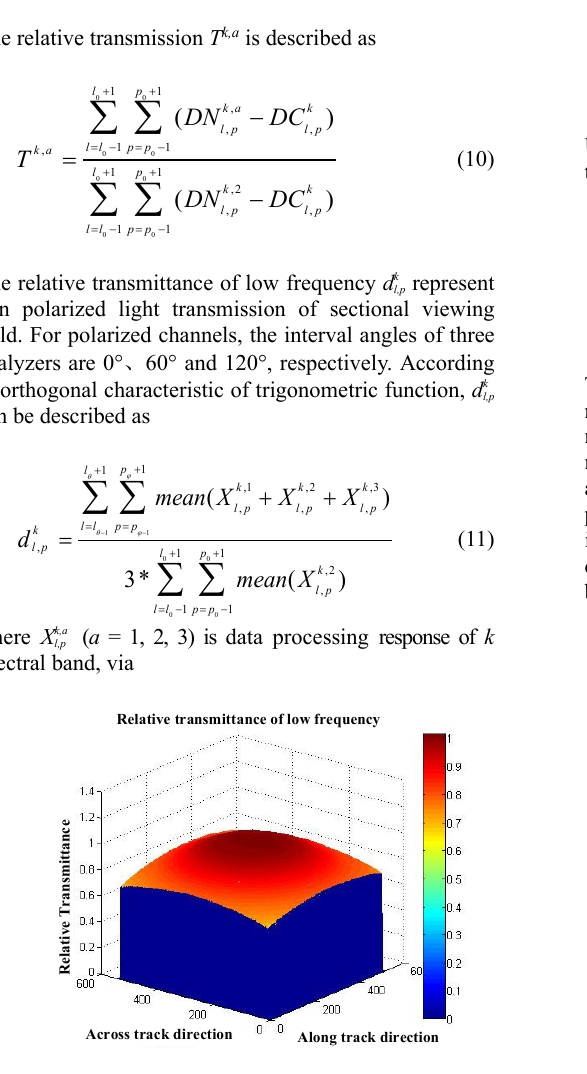
Figure 7. NURP measurement of SDPC 490nm P3 channel with test position matrix 7×7 (left) and 15×15 (right)